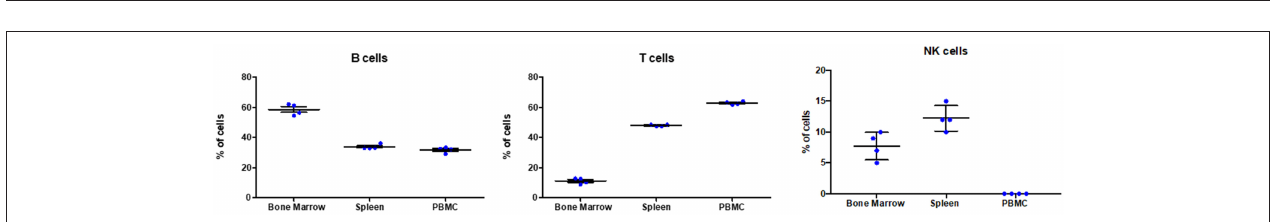
FIGURE 4 | Analysis of B, T and NK cell populations in blood, spleen and bone marrow from P. alecto . P. alecto B, T and NK cell populations from spleen, bone marrow and PBMC were analyzed by flow cytometry as described in the legend of Figure 1A . The percentages of B, T and NK cell populations in the bone marrow, spleen and PBMC of four P. alecto bats are shown.